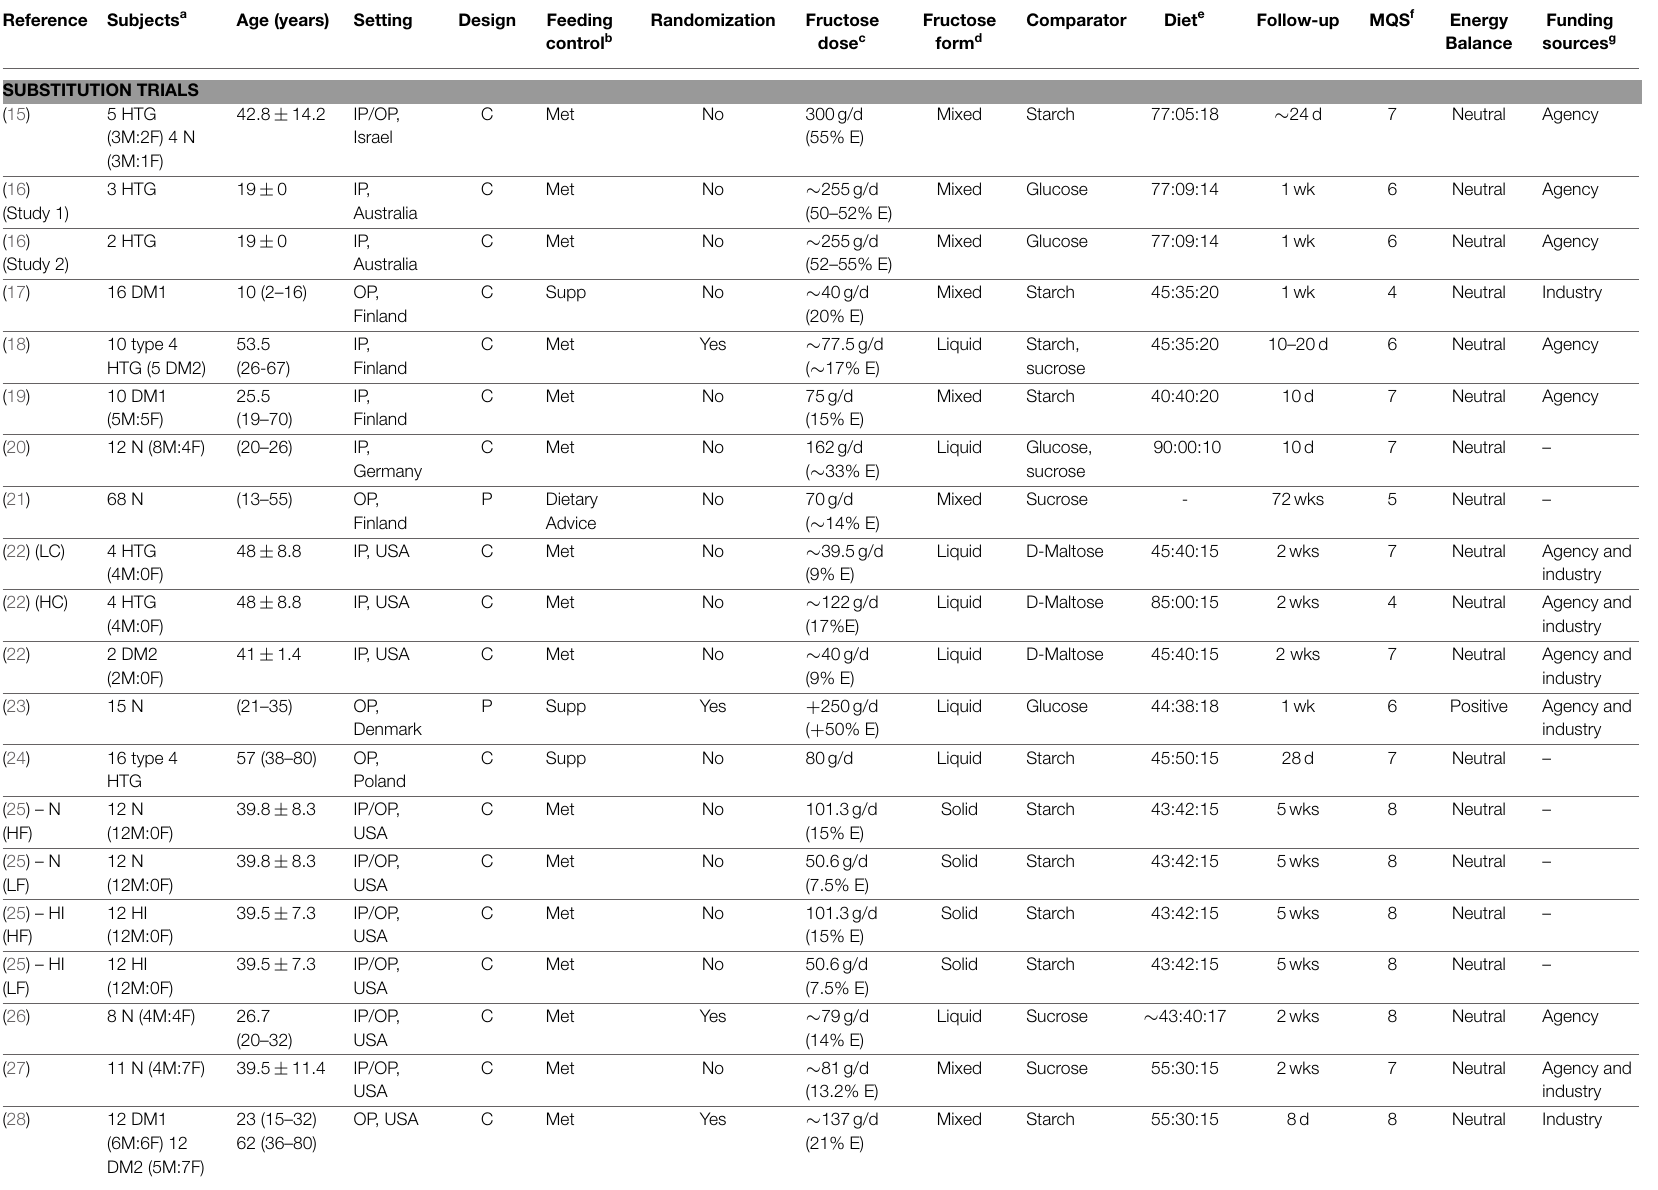
TABLE 1 | Characteristics of trials investigating the effect of fructose on cardiometabolic risk